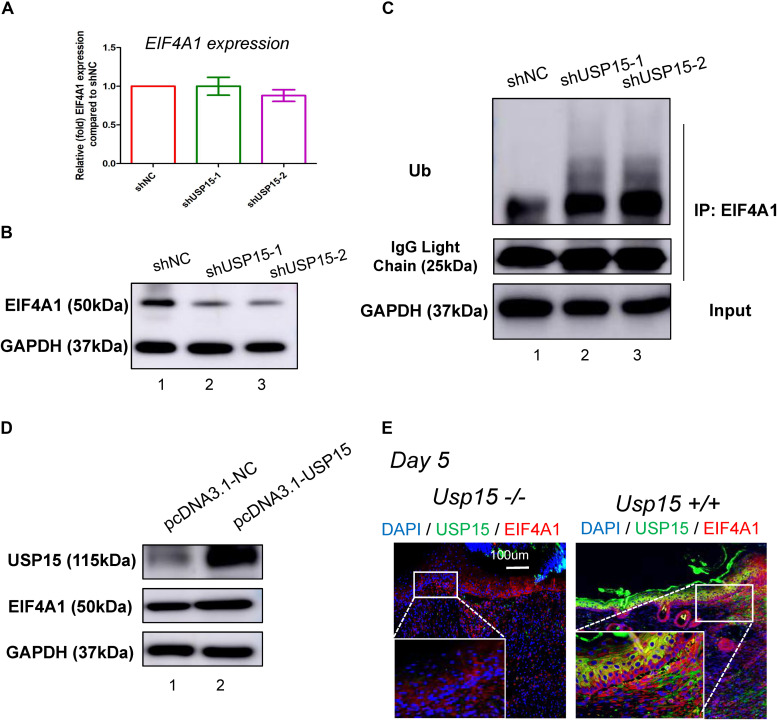
USP15 removed ubiquitin from EIF4A1. (A) Real-time PCR was performed to measure the EIF4A1 mRNA expression in the USP15-silenced keratinocytes (HaCaT). (B) A western blot assay was performed to identify the EIF4A1 protein expression in the USP15-silenced keratinocytes (HaCaT) cells. (C) A coimmunoprecipitation assay was performed to measure the ubiquitination level of EIF4A1 after inhibiting USP15. (D) A western blot assay was performed to identify the EIF4A1 protein expression in the USP15-overexpressed keratinocytes (HaCaT) cells. pcDNA3.1 was used as vector for overexpression. pcDNA3.1-NC was referred as control. (E) Immunofluorescence of USP15 and EIF4A1 in the Usp15 knockout mice and their wild-type littermates. Scale bar: 200 μm.